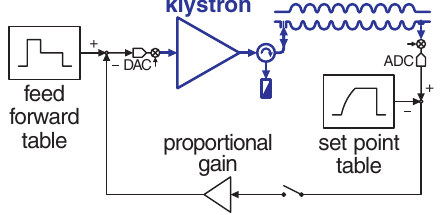
FIG. 3. (Color) Sketch of a pulsed rf superconducting cavity control loop. DACs in front of the vector modulator ( (cid:10) ) and ADCs after down converters ( (cid:10) ) are part of the digital control- ler